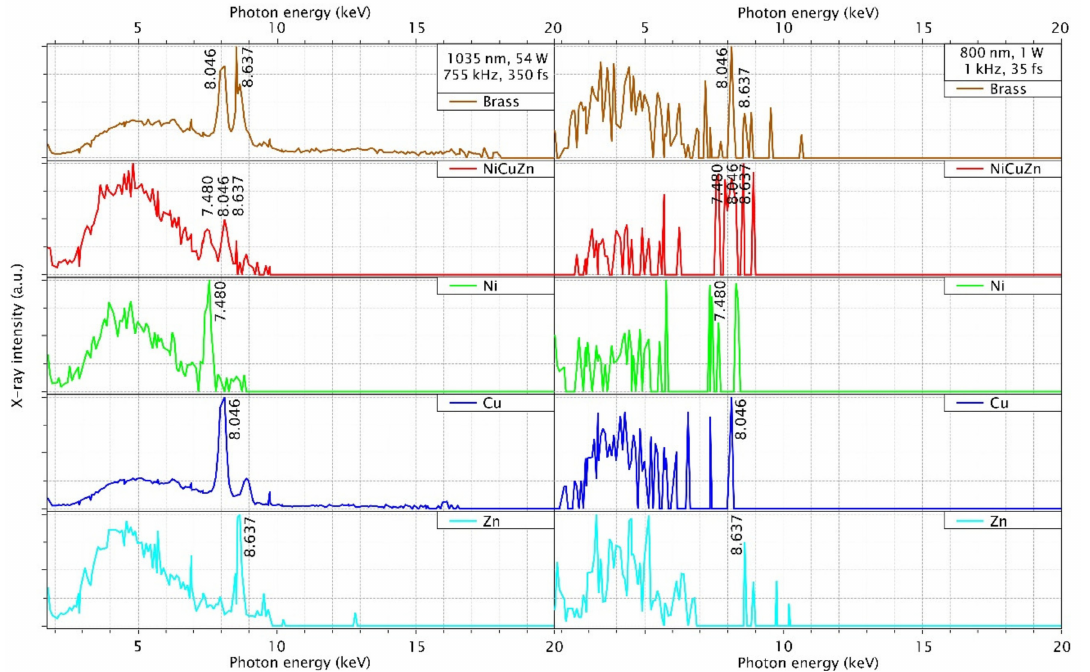
Figure 4. X-ray spectra measured for the different target material and the incident laser peak intensity listed as brass and NiCuZn alloy and its composition metals Ni, Cu, and Zn are investigated using a Silix lambda detector at a distance of 150 mm from interaction zone in air at an intensity 4.2 × 10 14 W/cm 2 ( left ) and 2.3 × 10 16 W/cm 2 ( right ) respectively for the above mentioned two